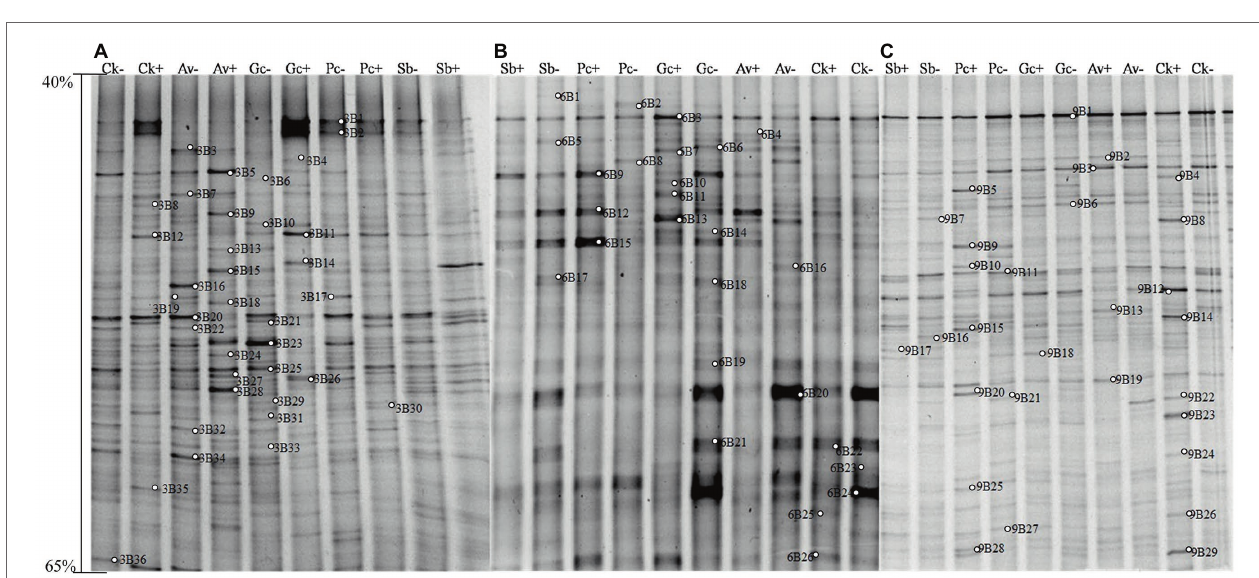
FIGURE 4 | DGGE pattern of nested PCR-amplified rRNA gene fragments of bacteria from P. tabulaeformis rhizosphere soils ( A-C represent rhizosphere soils were sampled at 3, 6, and 9 months after PWN inoculation) of different ECMF and DSE inoculation treatments after PWN inoculation. Lanes labeled Gc, Sb, Av, and Pc in A-C represent P. tabulaeformis seedlings were inoculated with G. cylindrosporus , S. bovines , A. vaginata , and P. chrysanthemicola , respectively; Ck as control group. “+” and “ − ” represent P. tabulaeformis seedlings were inoculated with PWN and were not inoculated with PWN, respectively. The linear gradient used was from 40 to 65% denaturant. The bands labeled 3B1-3B36 in A , 6B1-6S26 in B , and 9B1-9B29 in C were selected and excised from the DGGE gels and used for cloning and